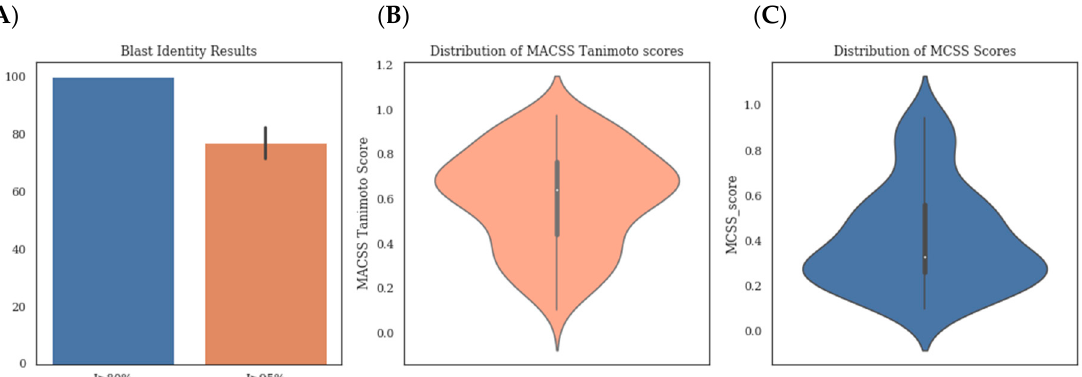
Figure 2. ( A ) Histogram representing the percentage of targets for which we obtained blast results with and identity higher than 80% (blue) and 95% (marron) ( B ) Distribution of Tanimoto MACSS score and ( C ) Tanimoto MCSS scores obtained for the ligands in the test set.